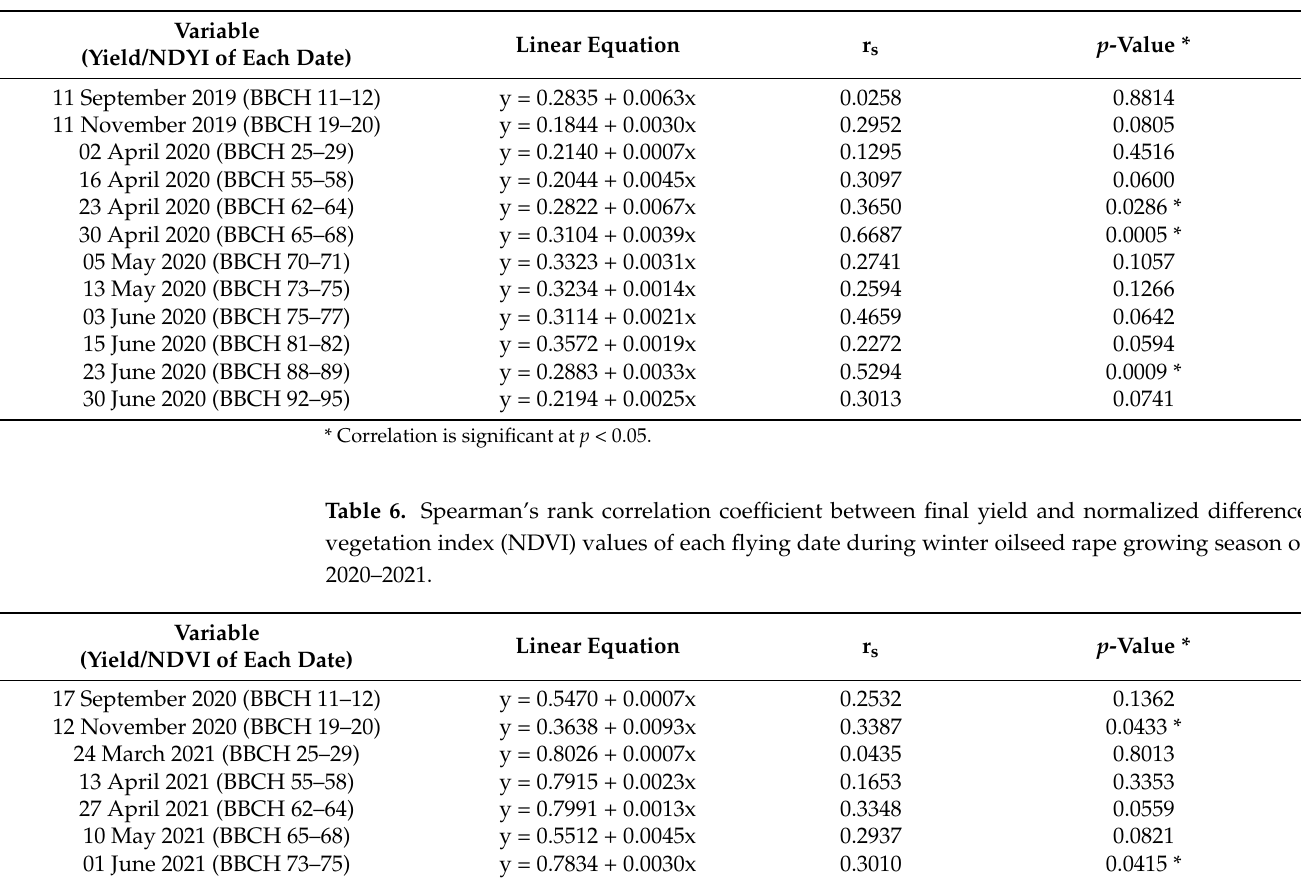
Table 5. Spearman’s rank correlation coefficient between final yield and normalized difference yellowness index (NDYI) values of each flight date during winter oilseed rape growing season of